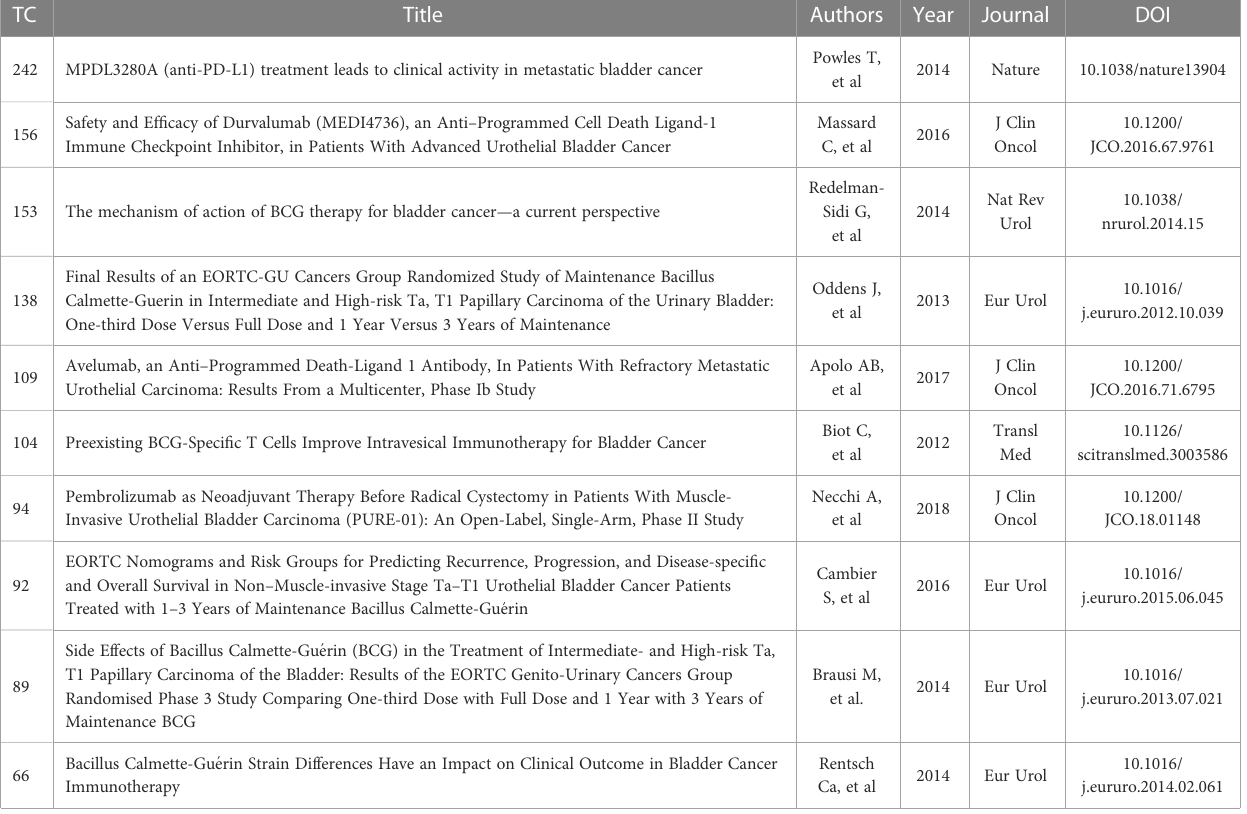
Side Effects of Bacillus Calmette-Gue ́ rin (BCG) in the Treatment of Intermediate- and High-risk Ta, T1 Papillary Carcinoma of the Bladder: Results of the EORTC Genito-Urinary Cancers Group Randomised Phase 3 Study Comparing One-third Dose with Full Dose and 1 Year with 3 Years of Maintenance